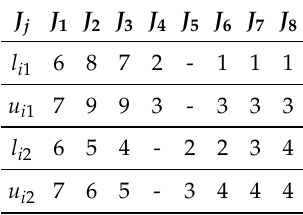
Table 1. The numerical input data for Example